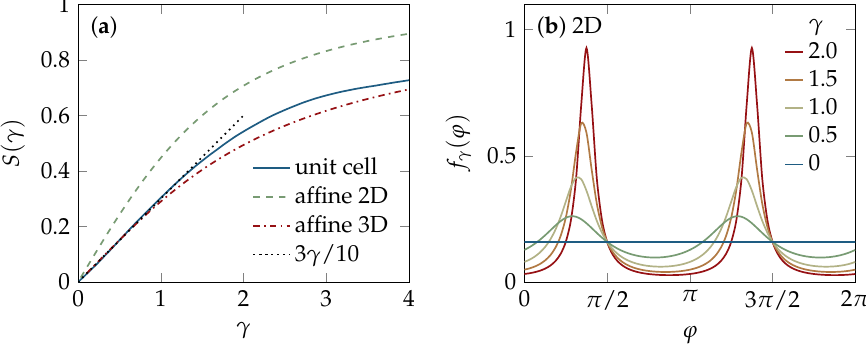
Figure 1. Shear alignment of tube segments. ( a ) Strain-dependence of the nematic order parameter S ( γ ) : affine scaling, as obtained for two- and three-dimensional solutions of phantom rods (Section 4.4), and the numerical estimate from the unit-cell model [21] (see Section 4.5). Up to strains of order one, the results are well captured by the linear asymptotic scaling of Equation (3), while S ( γ ) flattens out for larger strains, implying that perfect shear alignment is hard to achieve, even if quite substantial strains are imposed; ( b ) The angular distribution of the two-dimensional phantom-rod solution, according to Equation (19). With increasing strain the bimodal structure becomes more